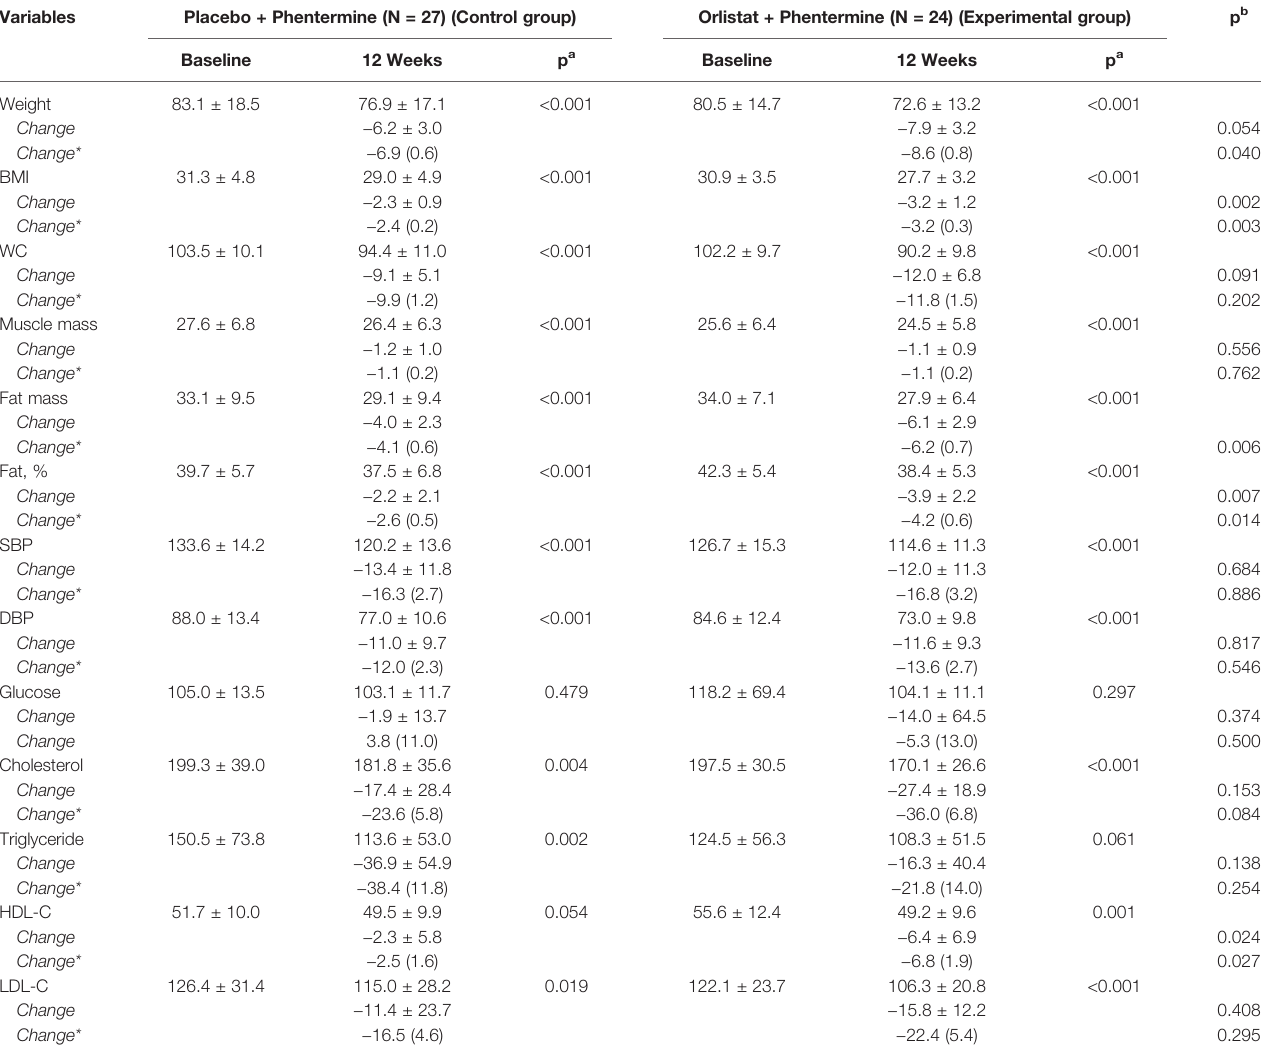
TABLE 1 | Baseline characteristics and Changes at 12 weeks in overweight or obese participants treated with placebo plus phentermine or orlistat plus phentermine. Variables Placebo + Phentermine (N = 27) (Control group) Orlistat + Phentermine (N = 24) (Experimental group) p b